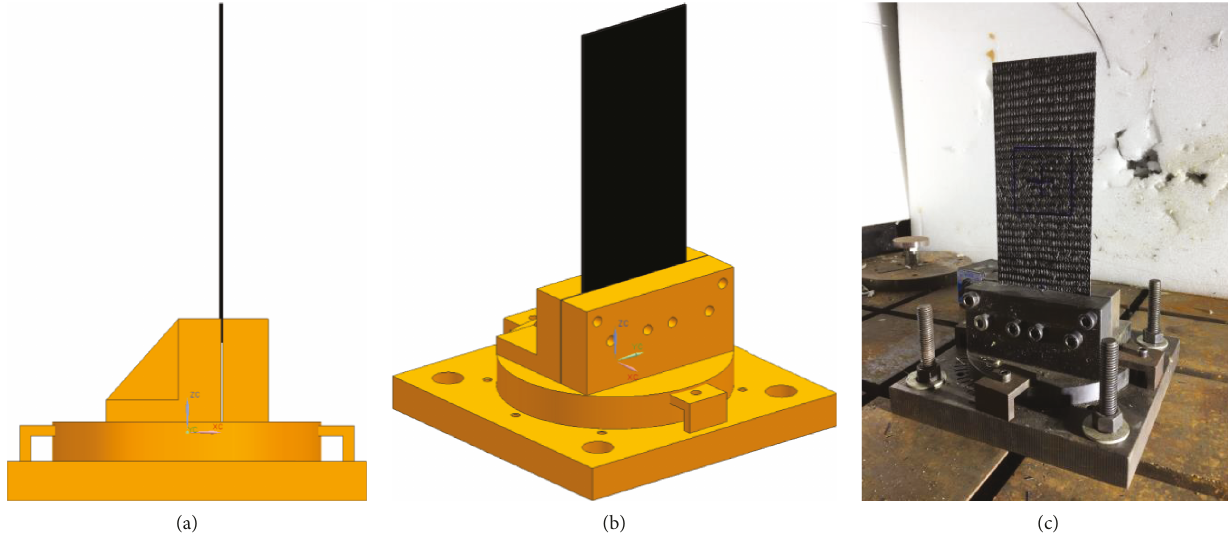
Figure 4: Clamping of the composite target during bird impact